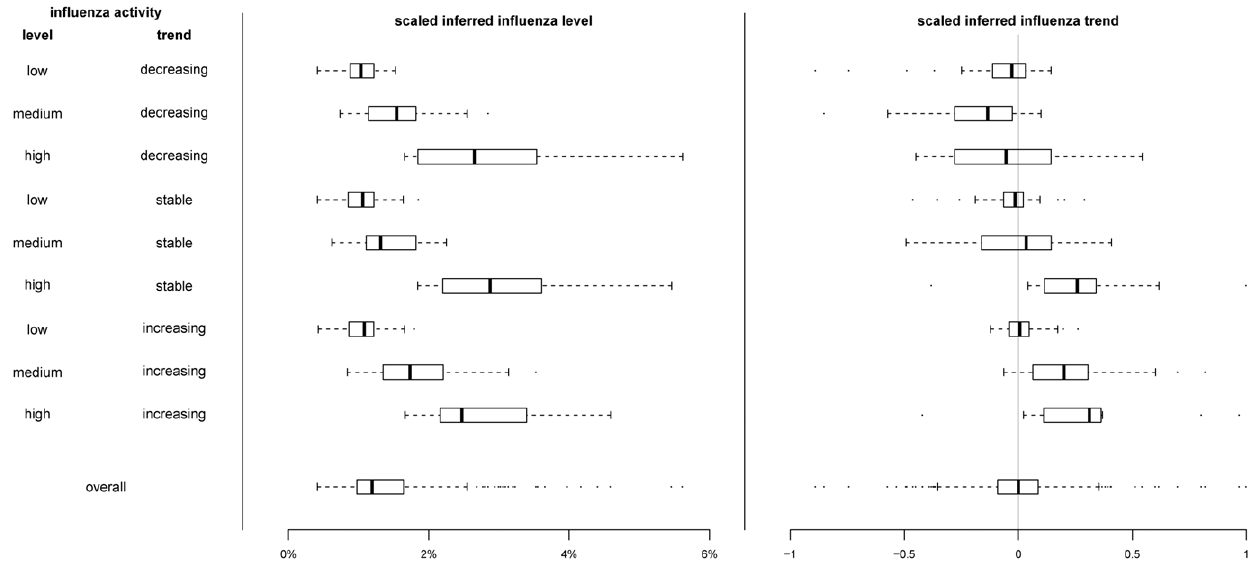
Figure 2. Box-plot of inferred influenza level and trend based on multivariate dynamic linear model utilizing four surveillance data streams including influenza-like illness consultation rates in public General Outpatient Clinics (GOPC) and private general practitioners (GP), school absenteeism rates, and number of consultations with patients with febrile illness in Designated Flu Clinics, under different patterns of influenza activity. Influenza activity was defined as low, medium or high if it is lower than 0.5%, between 0.5–2%, or higher than 2% respectively, defined as decreasing, stable or increasing if the percentage change between the following and preceding week is lower than 2 30%, between 2 30–30% or higher than 30% respectively. The inferred influenza level was scaled to the range of the influenza activity proxy measure (product of laboratory influenza isolation rate and GP ILI rate), while the inferred trend of influenza activity under the same model was scaled to the range [ 2 1, 1].